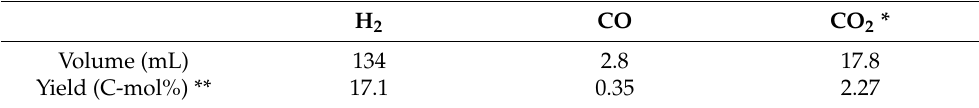
Table 1. Product gas yields after 30 min of solution-plasma treatment of sucrose under the same conditions as those in Figure 2. H 2 CO CO 2 * Volume (mL) 134 2.8 17.8 17.1 0.35